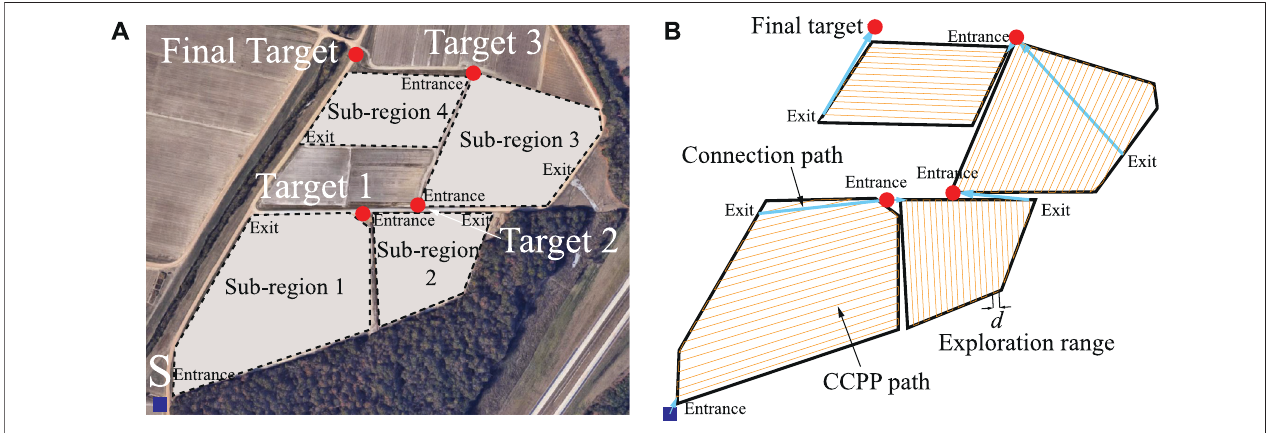
FIGURE 1 | (A) Illustration of multiple sub-regions exploration task. (B) The entire CCPP trajectory of multiple sub-regions with connection paths.